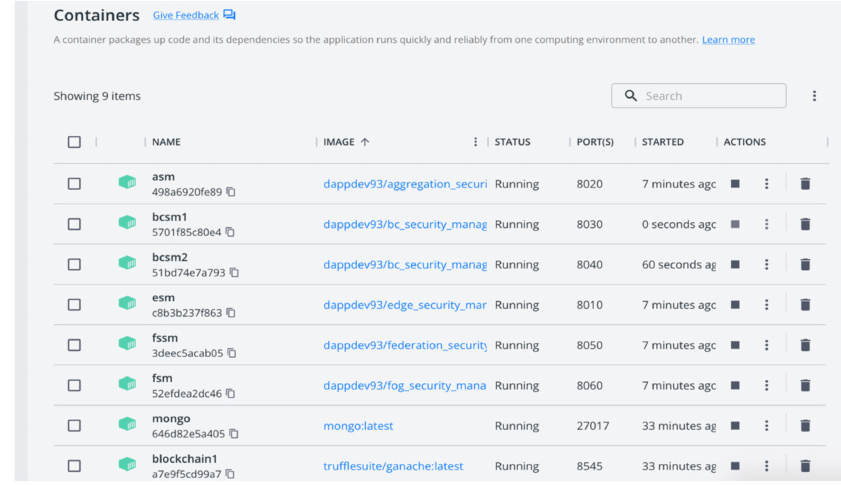
Figure 4. Screenshot of running the MS Docker containers for all the components of our framework.